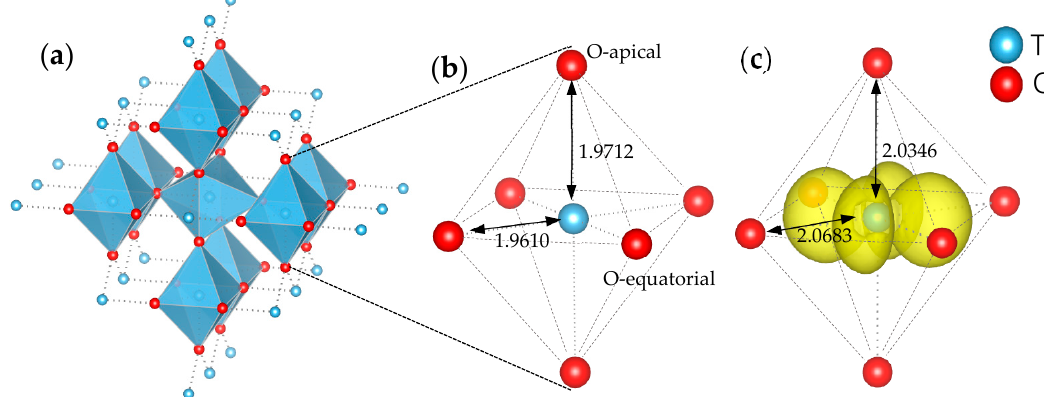
Figure 1. ( a ) Rutile crystal in view of TiO 6 building blocks. ( b , c ) Change of Ti–O bond length before and after a polaron is trapped at the central Ti atom. Yellow lobes correspond to net spin with density iso-surface of 0.01 e · A − 3 .